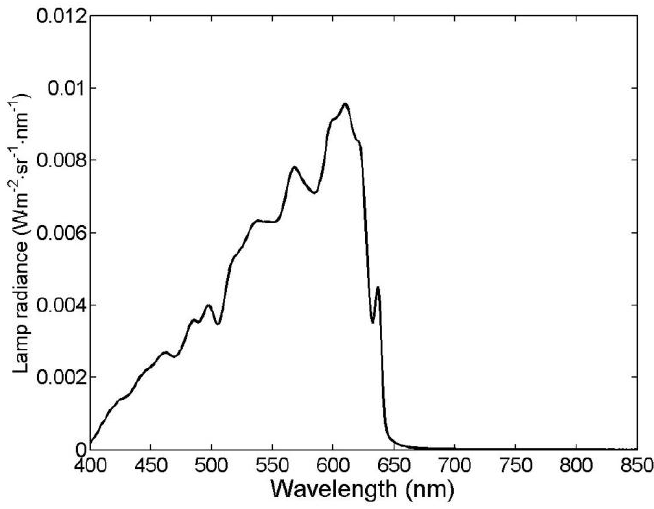
Figure 1. The experimental setup for leaf hyperspectral measurement. ( a ) Measurement configuration for leaf reflectance and backward fluorescence; ( b ) Measurement configuration for leaf transmittance and forward fluorescence.